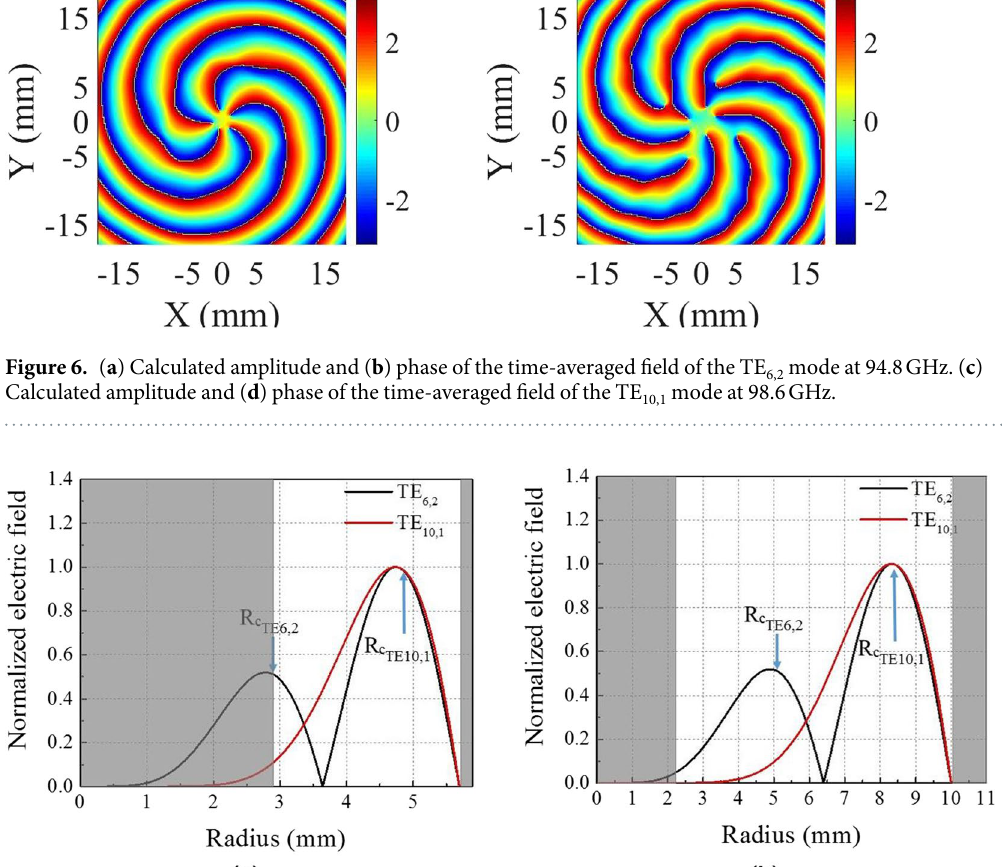
The experimental setup for rotating higher-order TE-mode generation using the QO-mode generator is shown in Fig. 8. A vertically polarized Gaussian beam is generated by a W-band waveguide feed Gaussian horn antenna connected to a vector network analyzer (VNA; Agilent, model no. N5247A). The frequency of the out- put Gaussian beam is varied by changing the frequency of the incoming RF signal from the VNA. The Gaussian beam escaping the horn antenna diverges as it propagates in free space. To focus the Gaussian beam at the caustic radius of the QO-mode generator, an off-axis ellipsoidal mirror has been designed and manufactured. The mirror focuses the Gaussian beam at a distance of 10.2 mm from the mirror and changes the direction of propagation by 90°. The QO-mode generator along with the inner rod is placed such that the reflected Gaussian beam is focused 2.94 mm vertically off from its axis, which is near to the caustic of the TE 6,2 mode. The Gaussian beam reflected from the ellipsoidal mirror passes through the translucent surface of the perforated cavity and excites the TE mode inside the QO-mode generator. The excited mode propagates along the length of the open-ended cavity